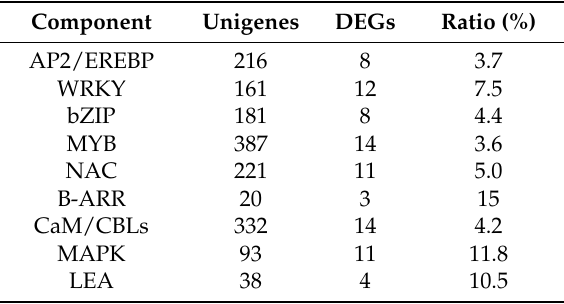
Table 3. Identified DEGs, unigene numbers and ratios of DEG/unigene.